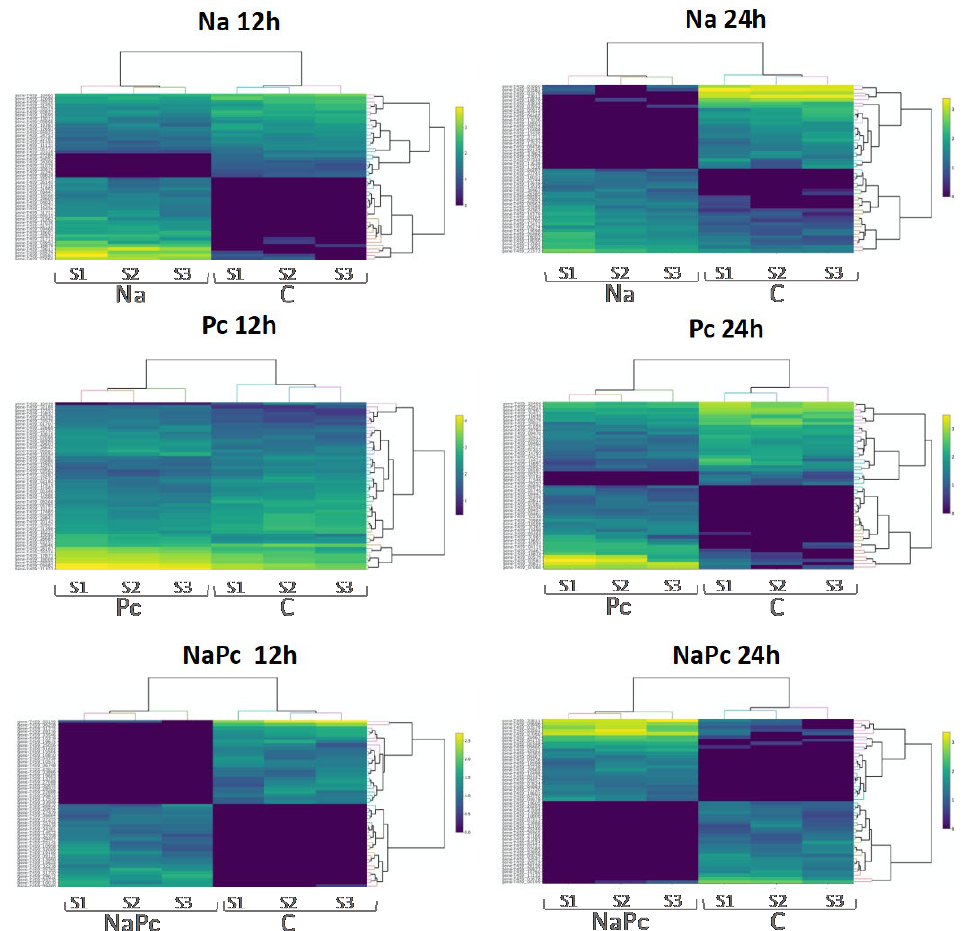
Figure 3. Genes expressed differentially in each condition. Heatmap of top 25 genes expressed differentially in Na ( Nacobbus aberrans) , Pc ( Phytophthora capsici) , and NaPc ( Nacobbus aberrans / Phytophthora capsici) treatments versus control (C). S1–S3: Samples analyzed. Identification of upregulated (yellow) and downregulated (purple) gene clusters.